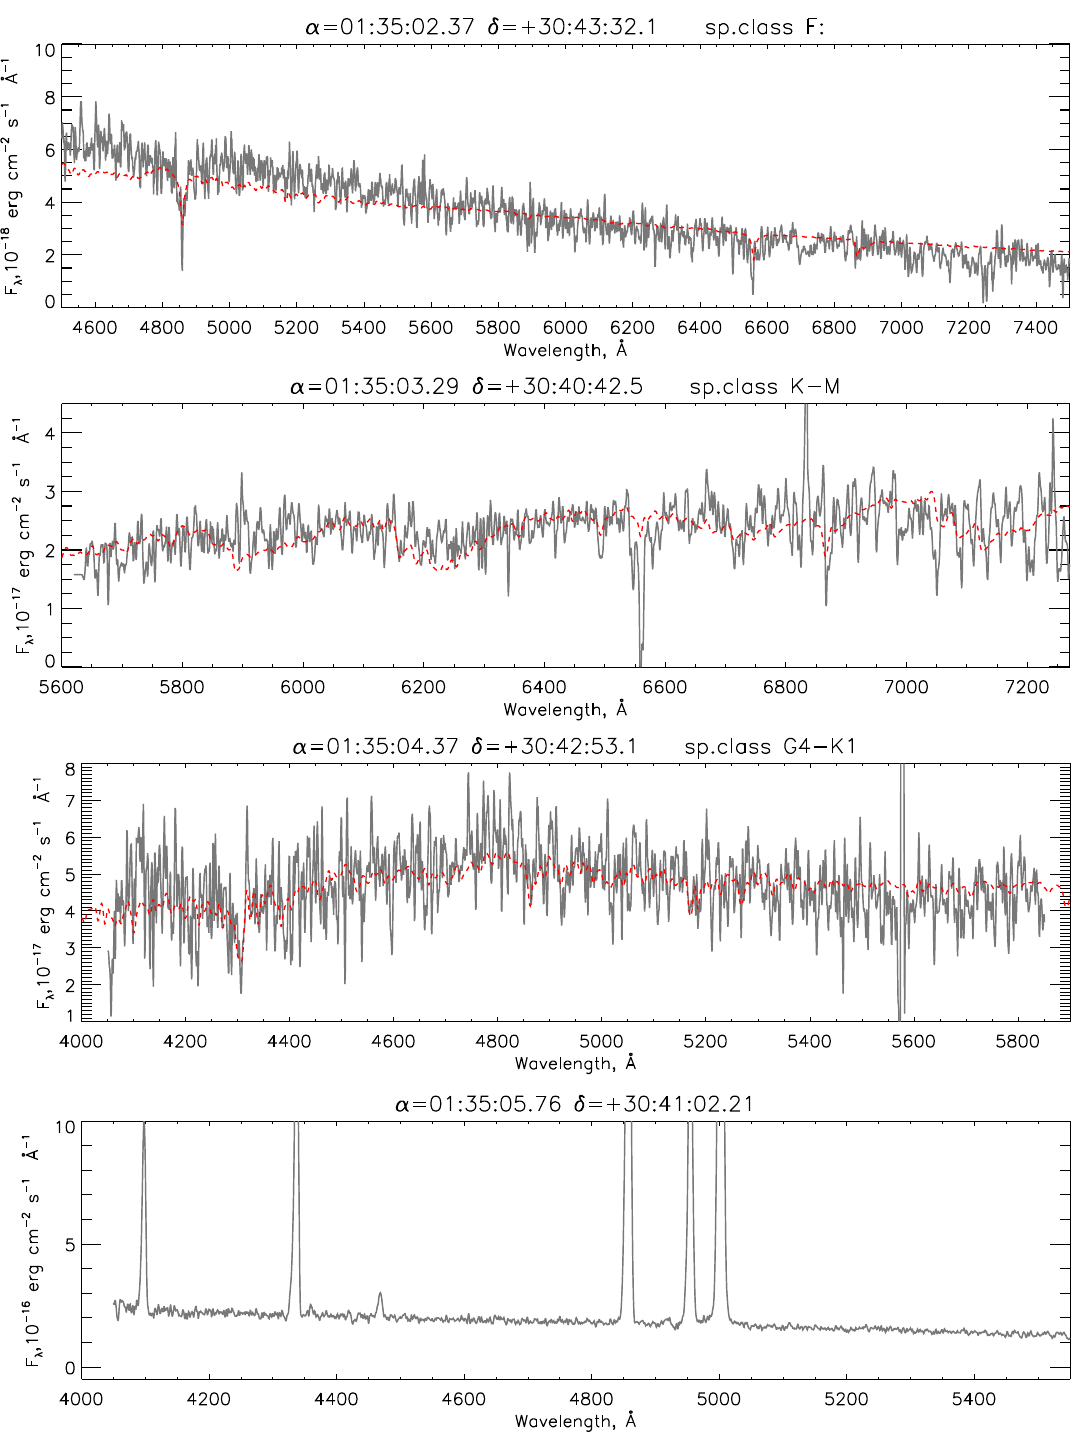
Figure A2. From the top panel downwards, spectra of the stars: J013502.37+304332.1, J013503.29+304042.5, J013504.37+304253.1 and J013505.76+304102.21. For comparison, the reddened spectra of HD128167 (F2V), HD102212 (M1III) and HD135722 (G8III) are shown by red dashed